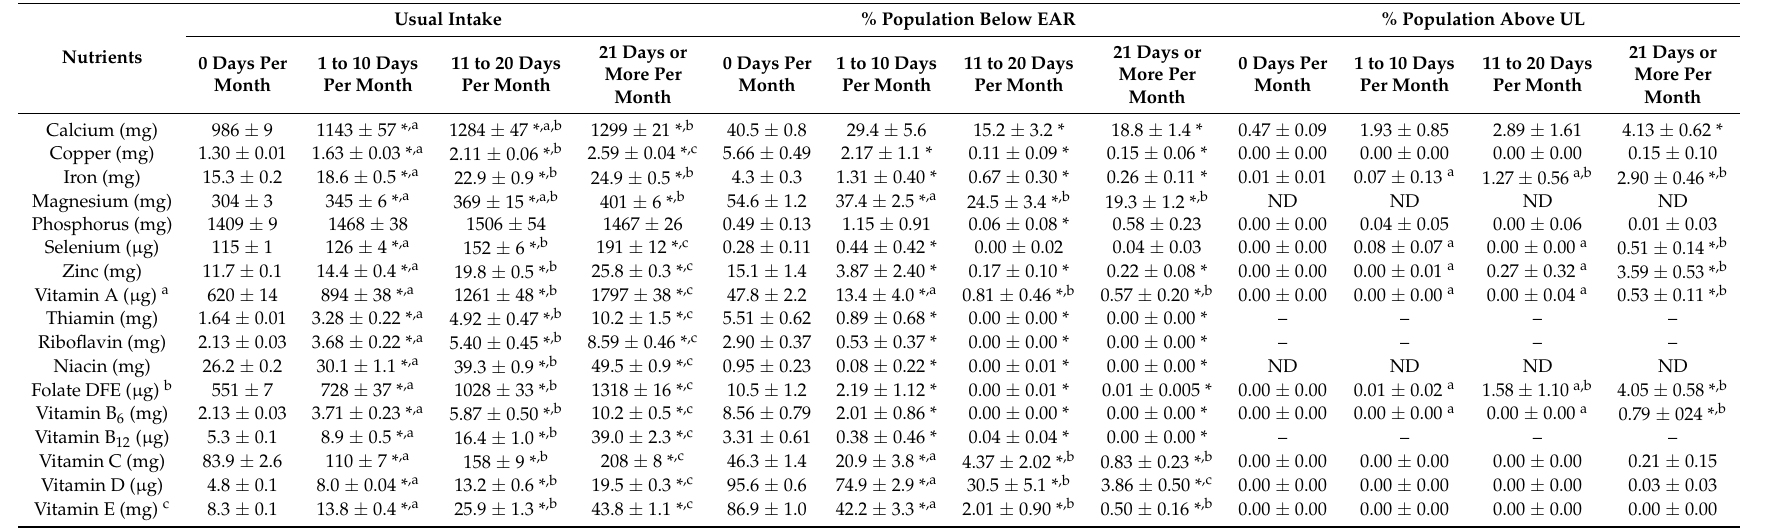
Table 2. Usual intake, prevalence of inadequacy (% population below EAR), and % population exceeding tolerable upper intake level (UL) of 17 micronutrients from food + MVMS by frequency of MVMS intake among all adults age 19 years and older. NHANES 2009–2012.